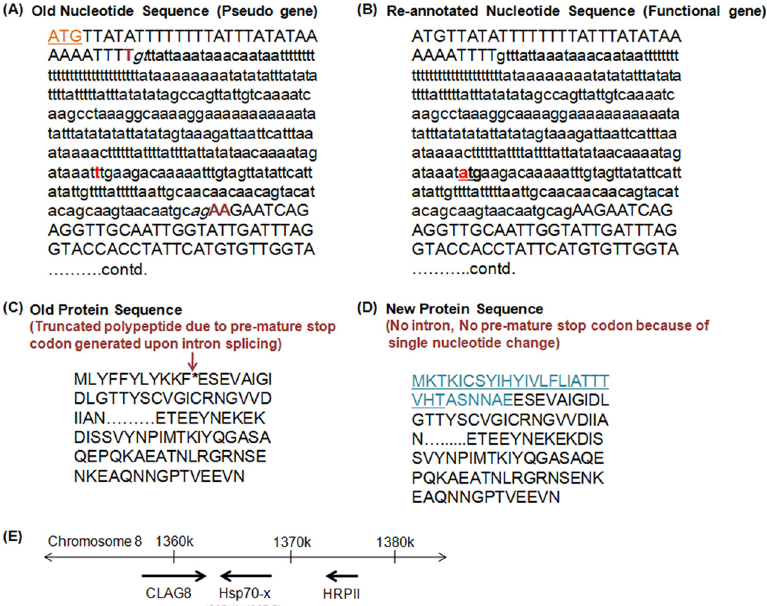
Figure 1. Re-annotation of PfHsp70-x sequence : (A) Original nucleotide sequence – intron is shown in lower case with splice sites in italics. ATG represents the start site, TAA is the in-frame stop codon created upon splicing and t is the erroneously designated SNP in the intron. (B) New nucleotide sequence – atg represents the alternate start site annotated following t > a change in the nucleotide sequence. Now the gene lacks intron and encodes the entire ORF. Sequence in lower case before atg is now a part of 5 0 UTR whereas the sequence after atg is part of the ORF. (C) Original protein sequence – * represents the in-frame stop codon which resulted in a truncated polypeptide. (D) New protein sequence – the sequence in blue is the new N-terminal sequence and underlined region represents the putative signal peptide. (E) Genomic location of PfHsp70- x